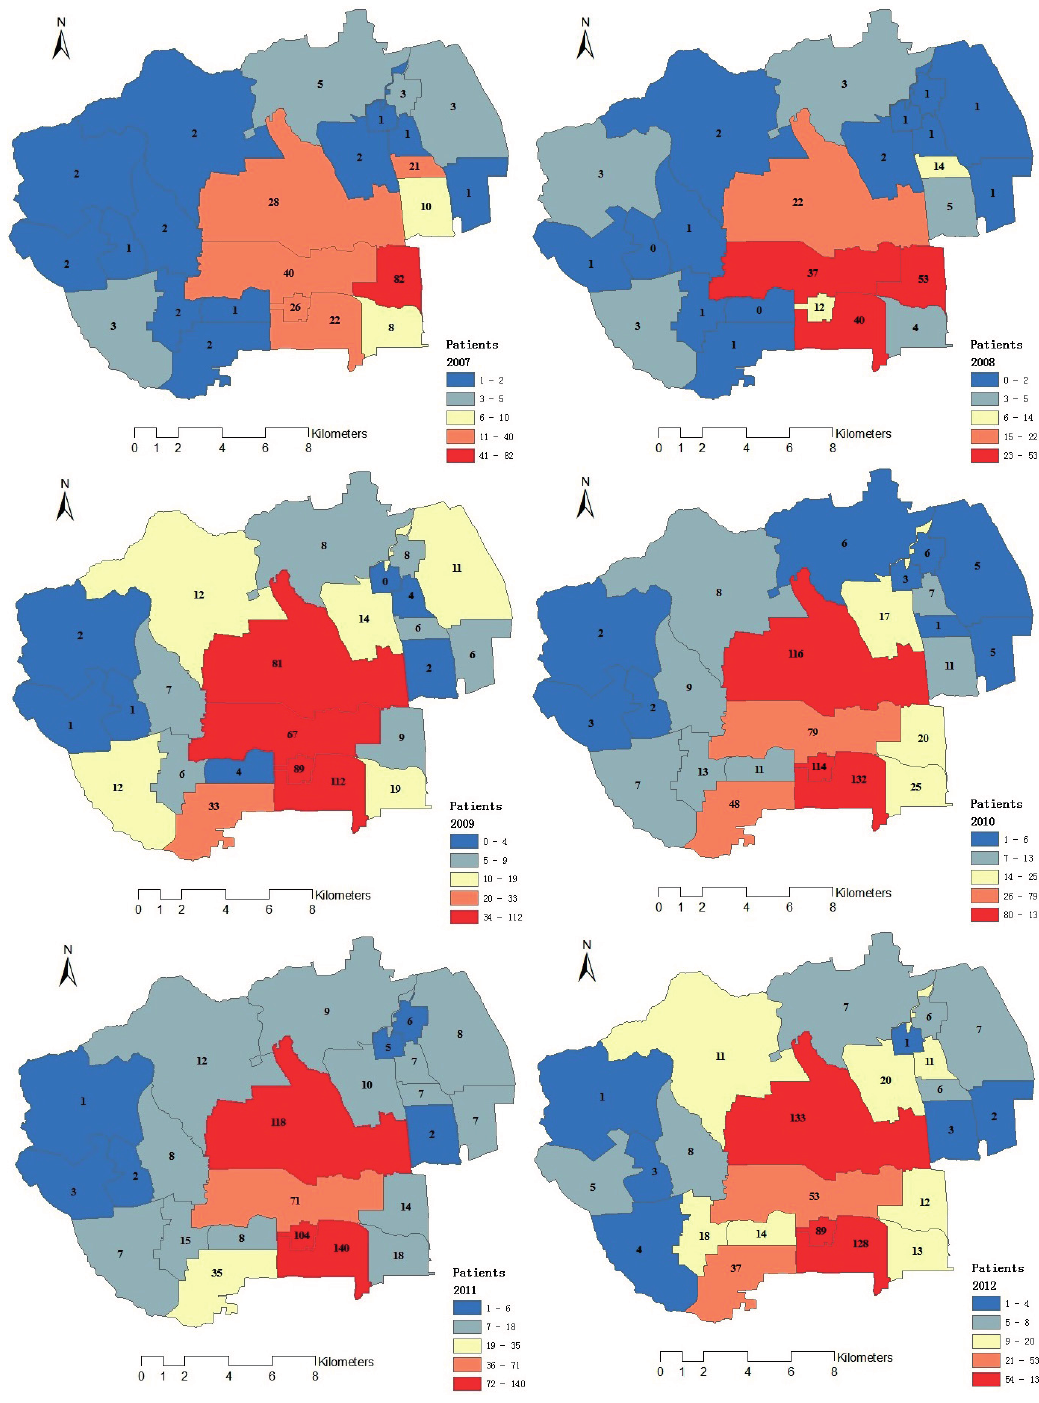
Figure 3. Spatial distribution of outpatients from 2007 to